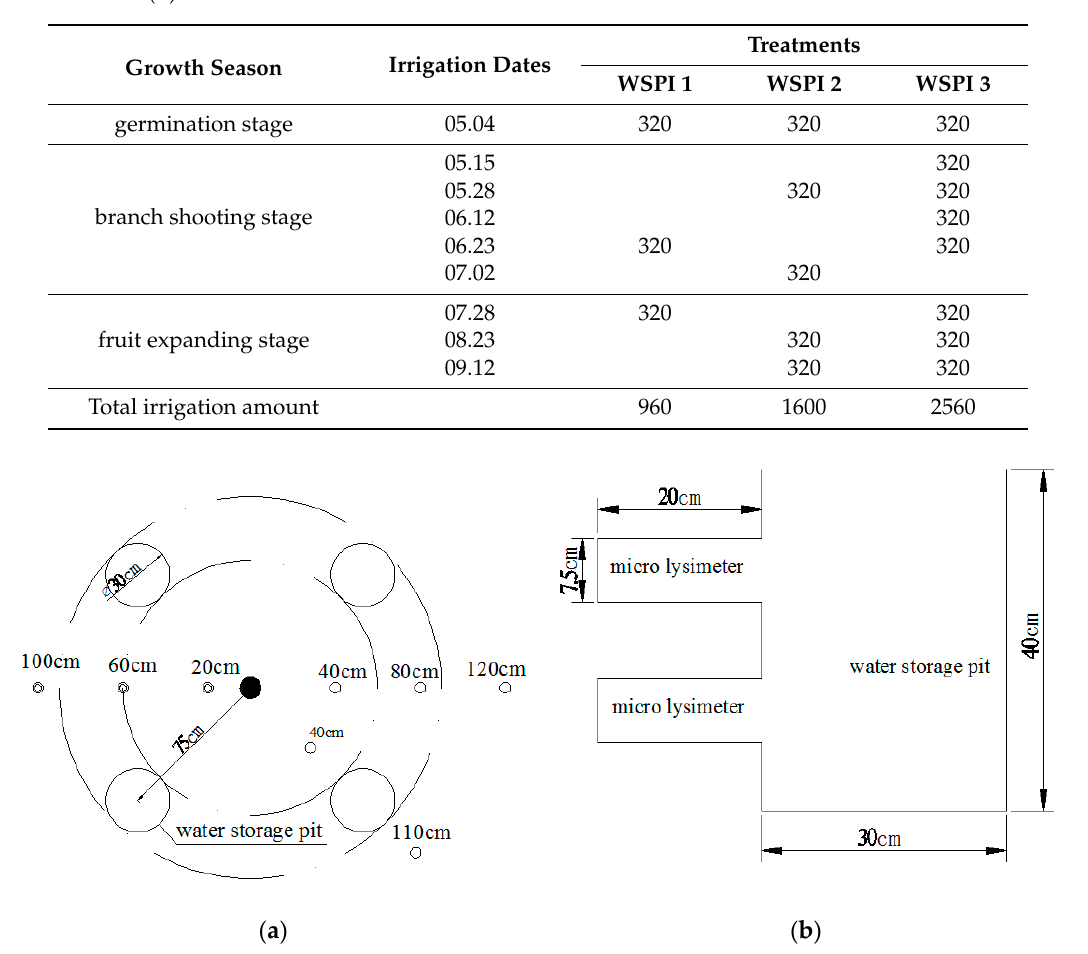
Table 2. Irrigation date and total amount of water applied under water storage pit irrigation (WSPI) conditions (L).